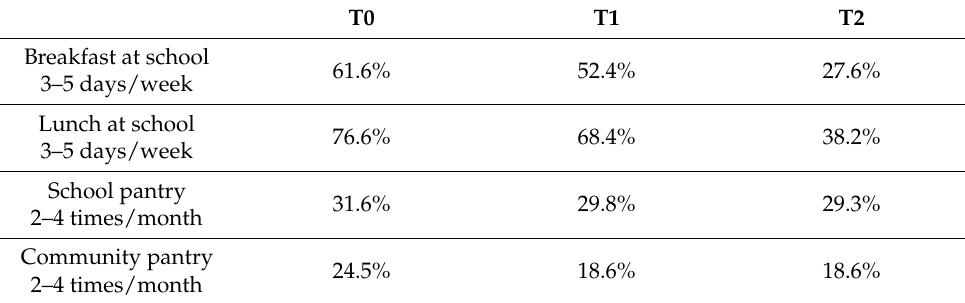
Table 3. Frequency of Nutrition Support Use by Time